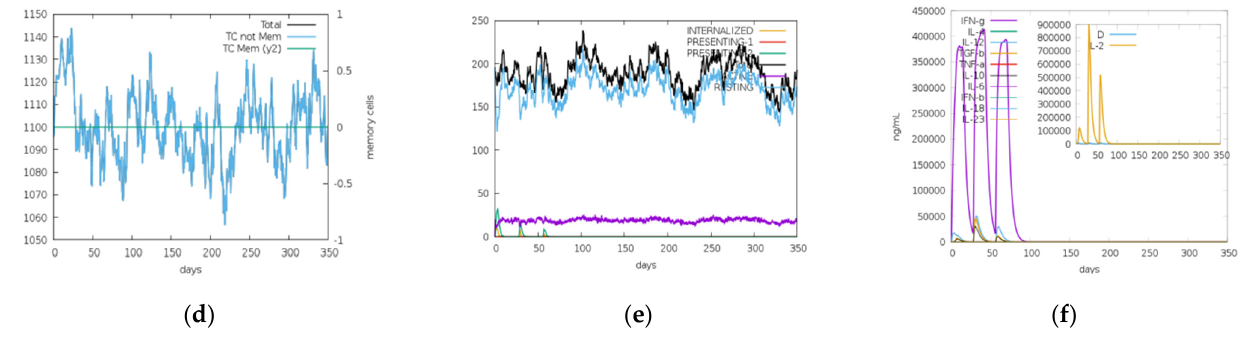
Figure 11. C-ImmSim server predictions for prM protein: ( a ) antigen and immunoglobulins (IgG1, IgG2, IgM, IgG, IgM, and antigens); ( b ) memory cell (B-cell) population; ( c ) helper T cell (HTL) population; ( d ) cytotoxic T cell (CTL) population; ( e ) macrophage population count per state; ( f ) cytokine and interleukin (IL) production with Simpson index (D) of the immune response.